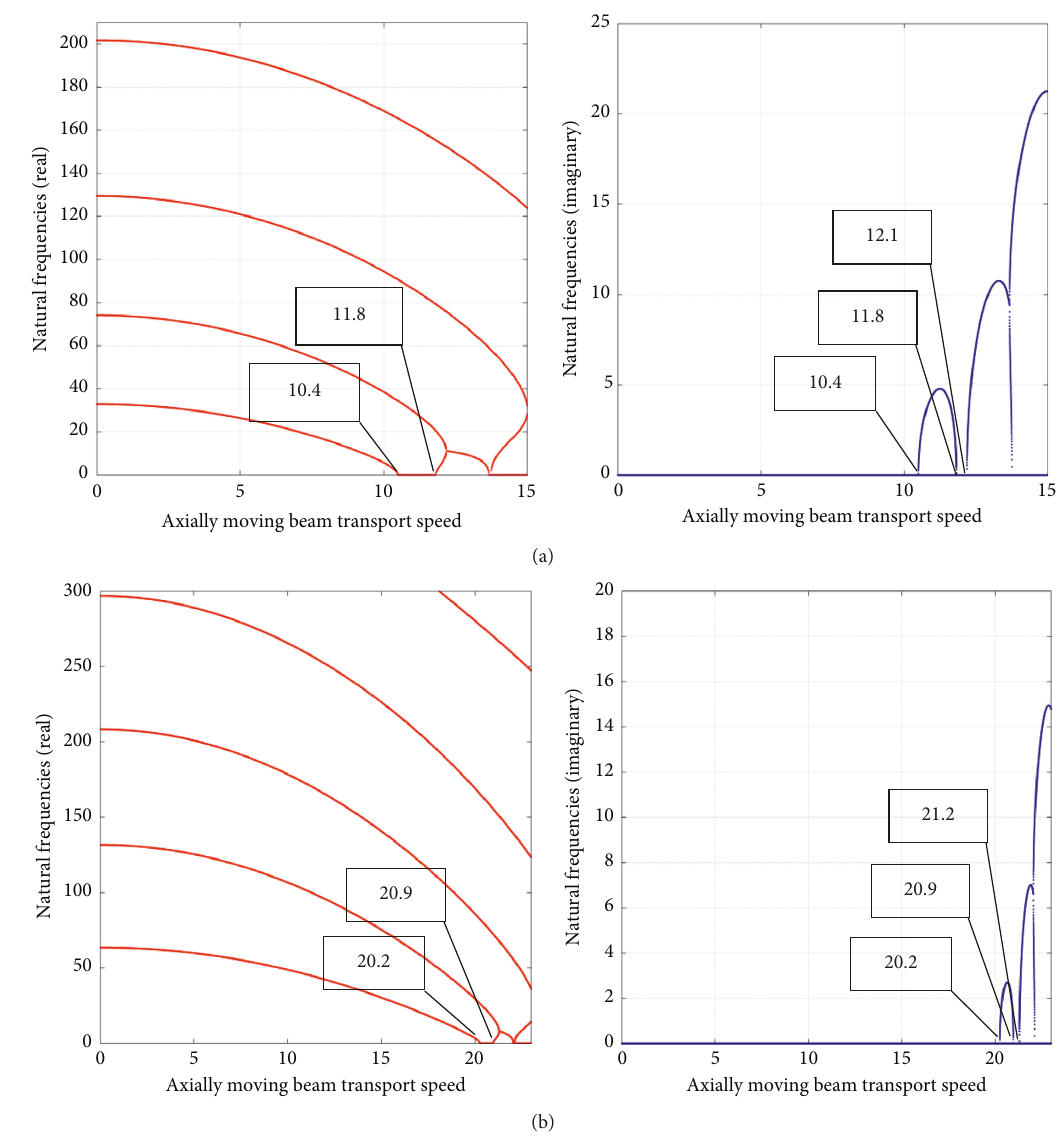
Figure 4: Real and imaginary parts of frequencies vs. axially moving speed. (a) μ � 10 and (b) μ � 20. Table 1: Effect of tension parameter ( μ ) on critical